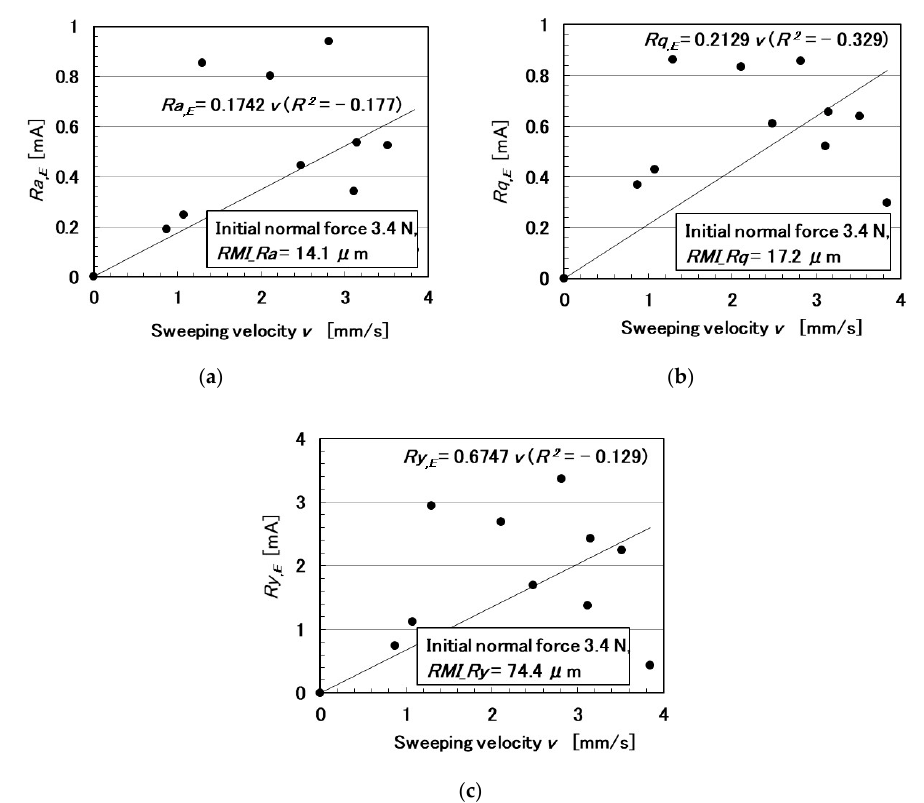
Figure 9. Relationship between electric current and sweeping velocity: ( a ) Ra .; ( b ) Rq .; and ( c ) Ry .